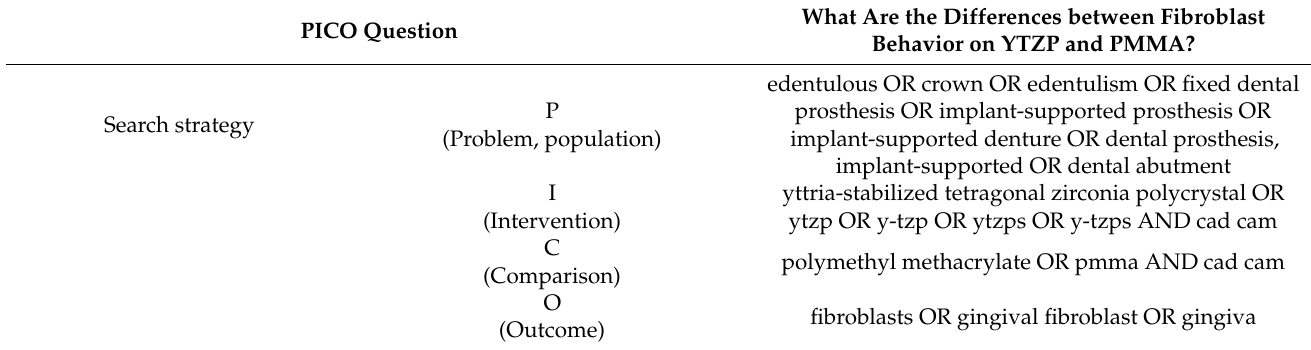
Table 1. Overview of the search strategy following the PICO format.